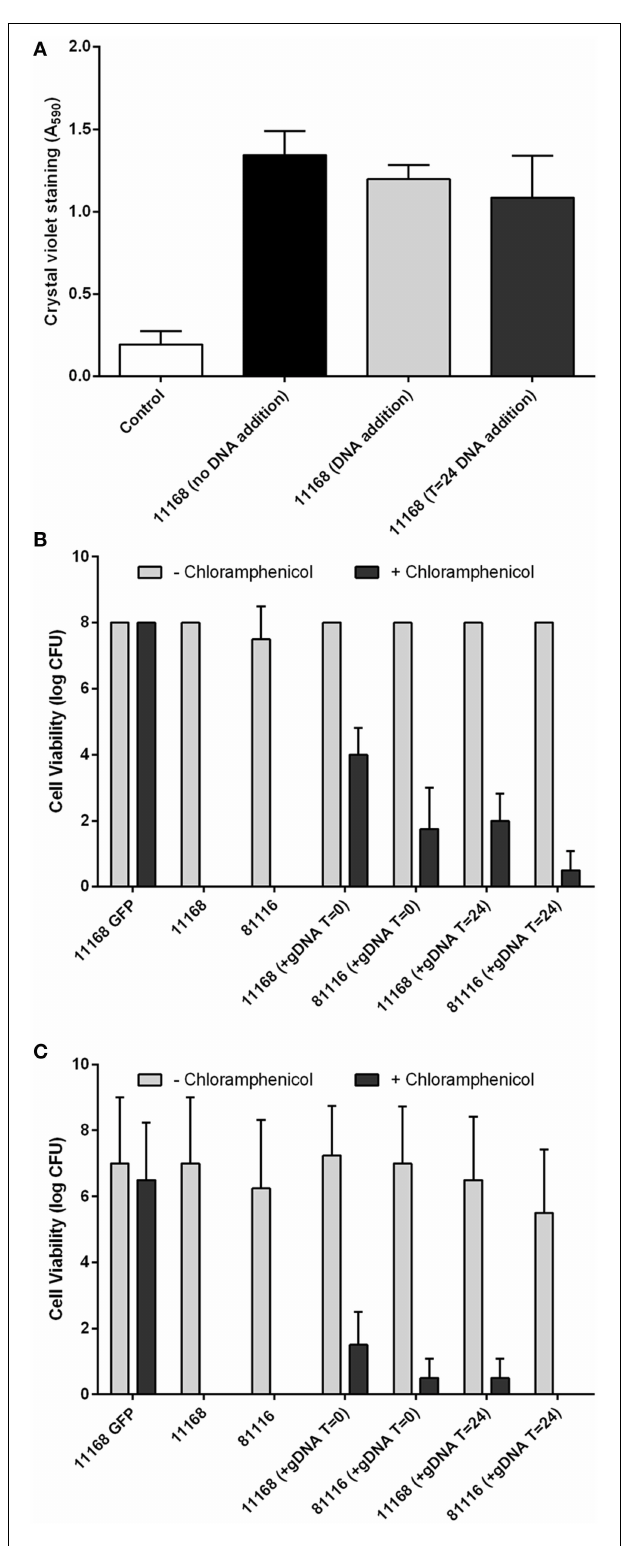
FIGURE 6 | C. jejuni NCTC 11168 and 81116 can acquire genetic traits from exogenous DNA during static incubation. C. jejuni NCTC 11168 and